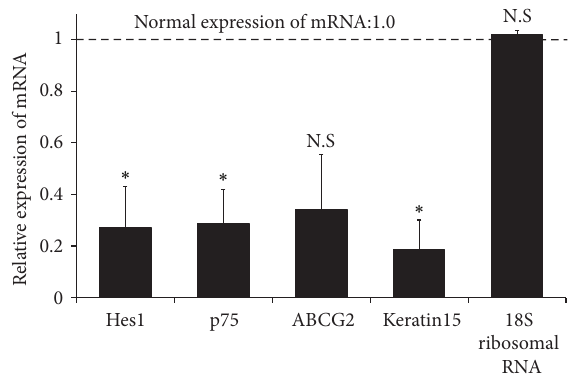
Figure 2: Diminished mRNA expression levels of stem cell markers in diabetic cornea. The transcript levels of p75 , hairy enhancer of split 1 ( Hes1 ), Abcg2 , and Keratin15 in the cornea are shown. The mRNA expression levels of p75, Hes1 , and Keratin15 signif- icantly decreased in diabetic corneas. A reduction of Abcg2 was also observed, although this was not statistically significant. 18S ribosomal RNA expression showed no significant difference between diabetic corneas and normal corneas. Statistical significance for mRNA levels is calculated on fold-change values over those of dia- beticcorneas.ThedottedlinerepresentsthemRNAexpressionlevels in normal corneas (normal expression of mRNA: 1.0). Statistical evaluation of data was performed with the unpaired t -test. The bars represent the mean ± standard error of the mean (SEM) ( ∗ 𝑃 < 0.05 ).